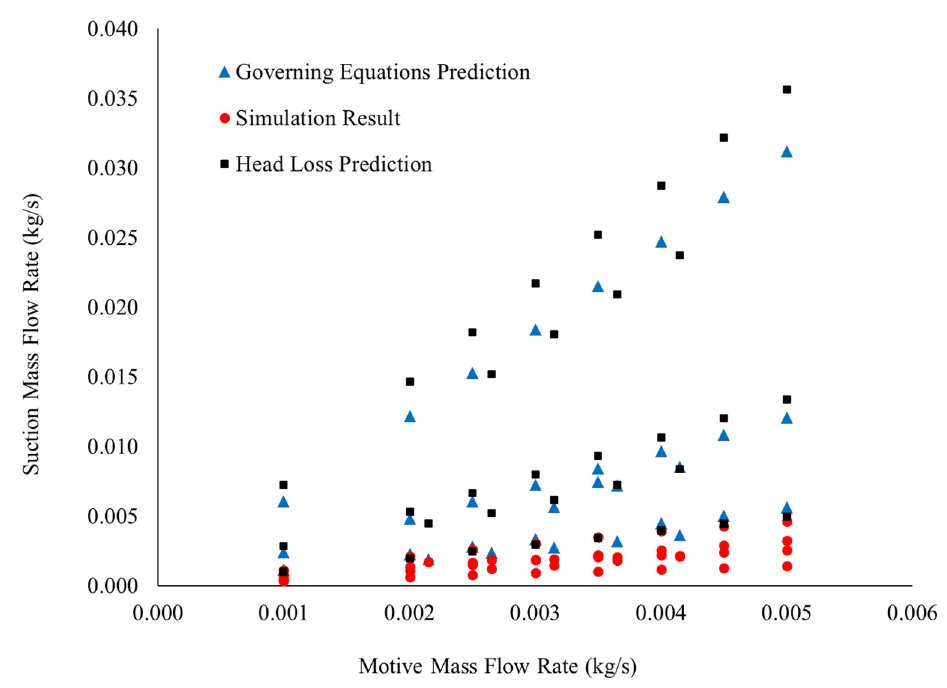
Figure 8. Head loss predicted suction mass flow rate, governing equations predicted suction mass flow rate, and validated simulation suction mass flow rate vs. motive mass flow rate. The suction mass flow rate predicted by the governing equations method is 270% higher than the simulation result. The suction mass flow rate predicted by the head loss method is approximately 380% higher than the mass flow rate from the validated simulation. The simulation has an average error of 8% relative to the experimental data.